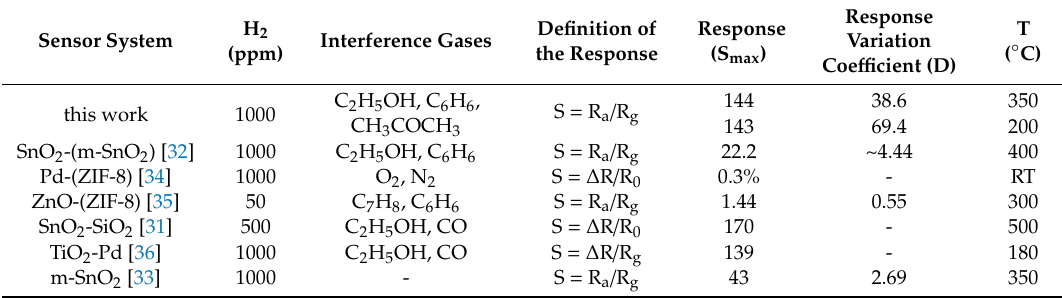
Table 2. Comparisons of the present study with the previously published